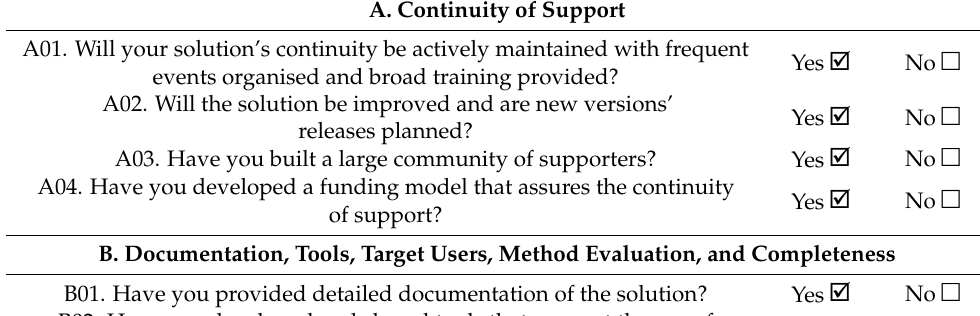
Table 1. Applicability control list. The symbol  depicts a completely addressed control question.  indicates an area that has been partially covered.